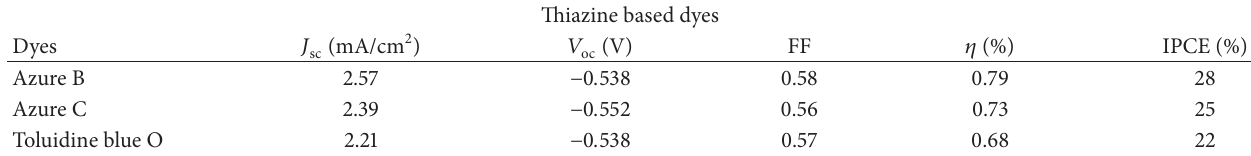
Table 5: DSSC performance parameters of thiazine based dyes.